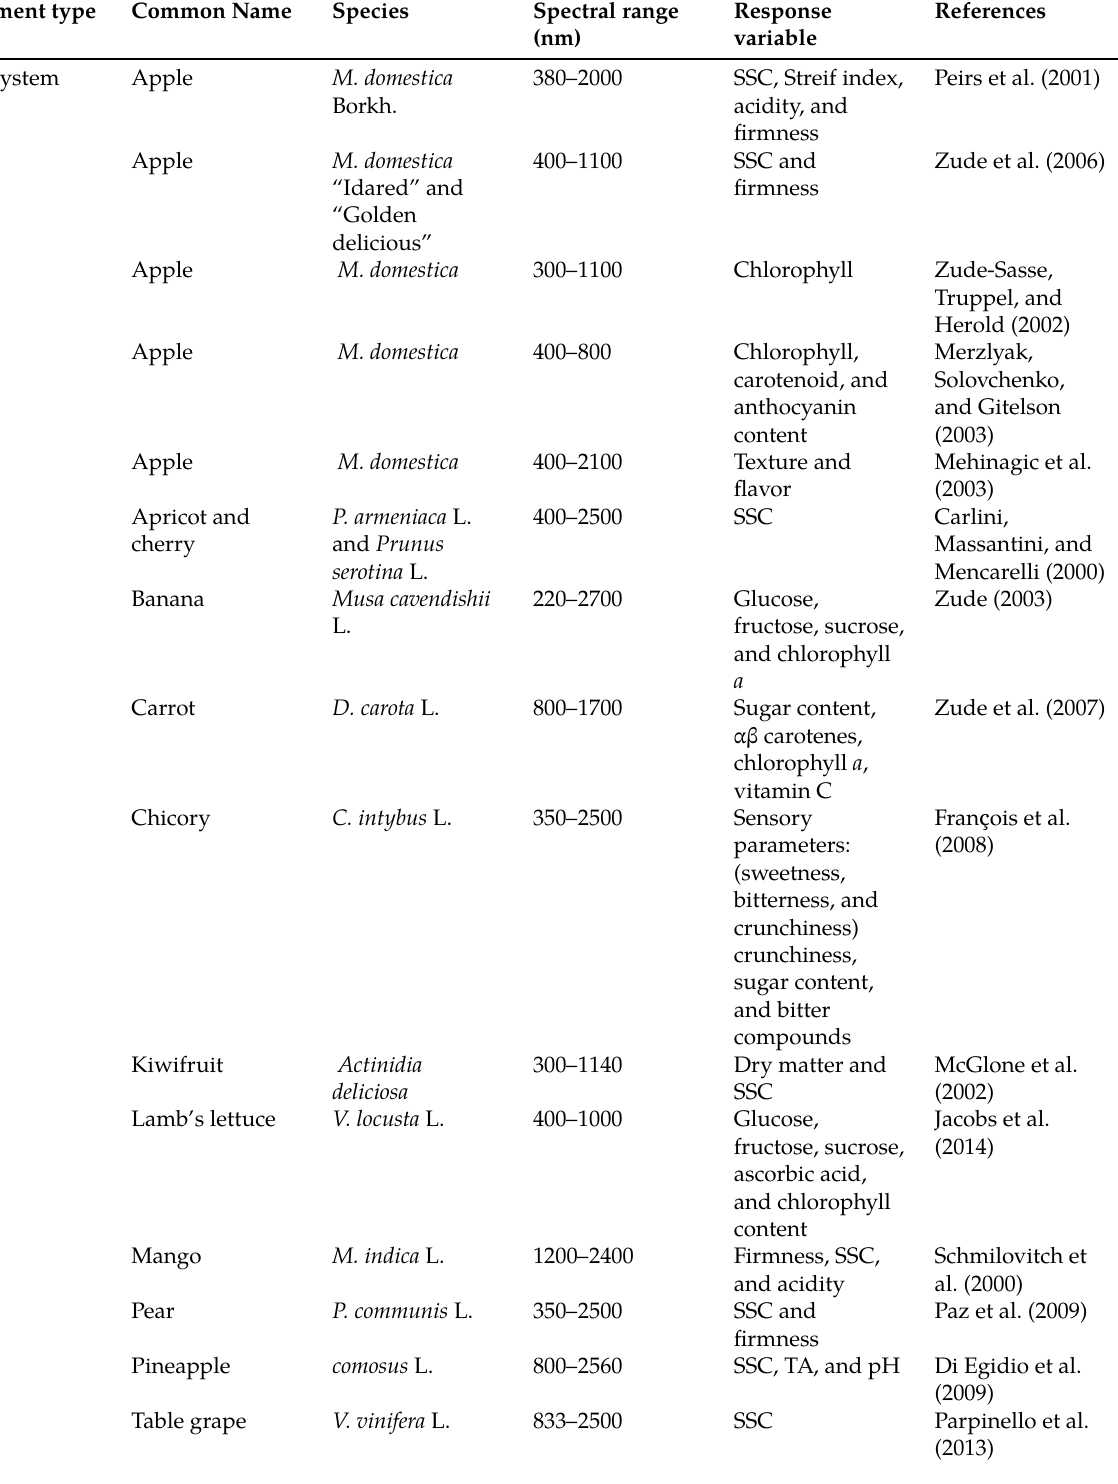
Table 3: Selection of applications of vis/NIR and NIR spectroscopy on fruit and vegetables. Instrument